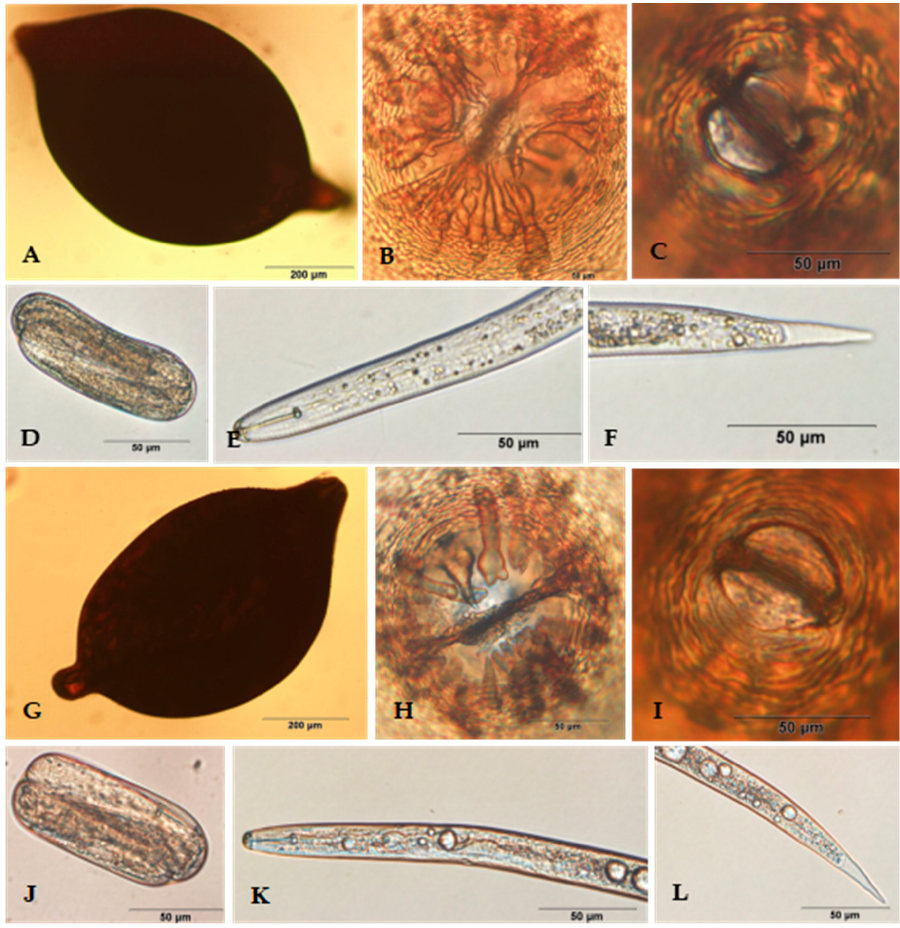
Figure 1. Morphological characteristics of SCN ( A – F ) and SBCN ( G – L ). ( A ) and ( G ) Cyst; ( B ) and ( H ) Bullae; ( C ) and ( I ) Ambifenestrate; ( D ) and ( J ) Egg; ( E ) and ( K ) Stylet; ( F ) and ( L ) Hyaline region.